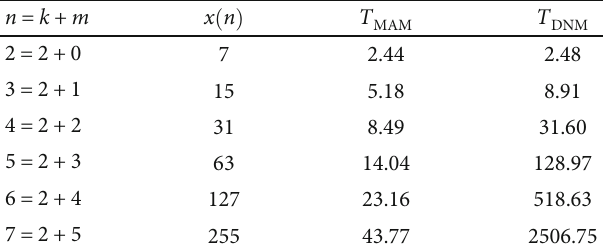
Table 5: Comparison of CPU time between MAM and DNM via quadratic basis with k = 2, τ = 0 : 001 , and α = 0 : 1 for Example